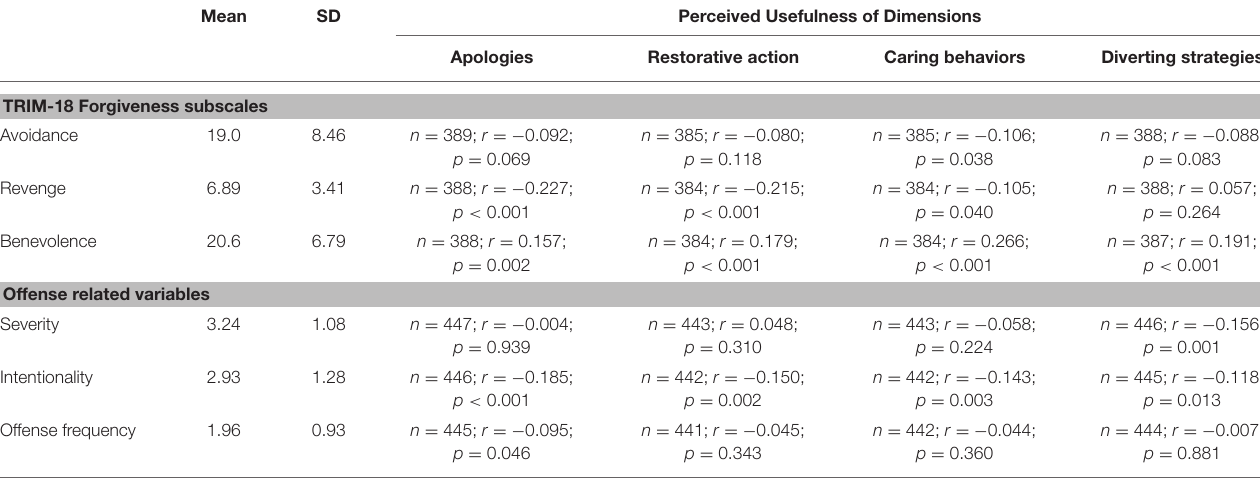
TABLE 2 | Correlations among forgiveness seeking strategies and offense characteristics and